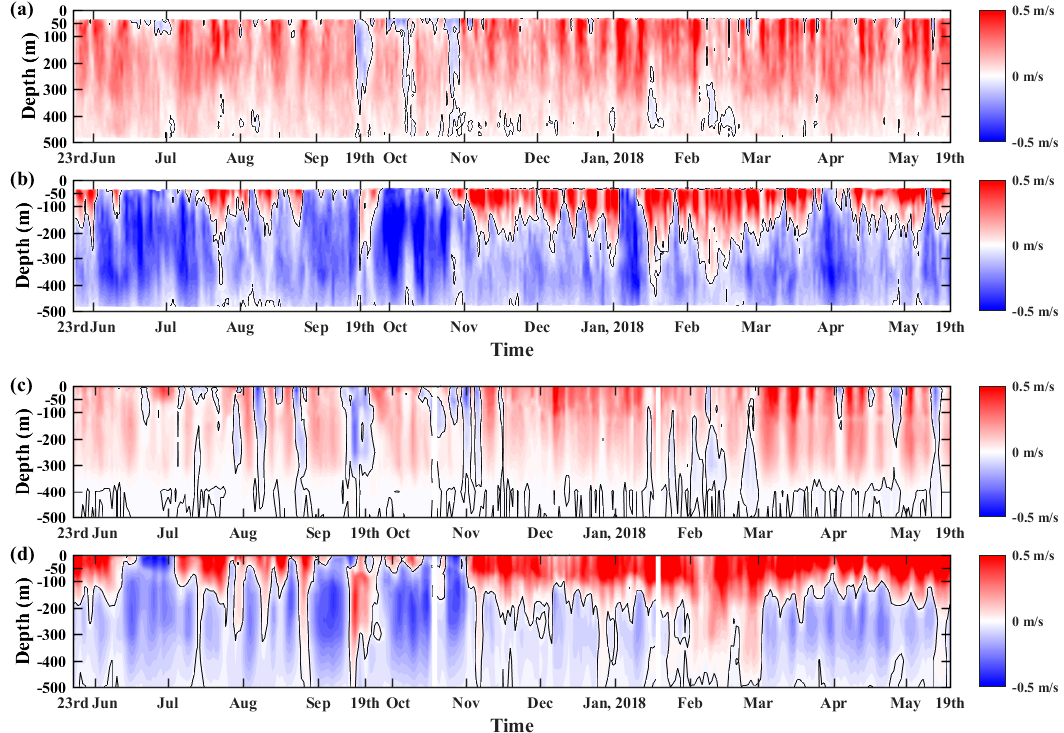
Figure 2. Current velocity distribution as a function of depth and time derived from ( a, b ) in situ observations and ( c, d ) analysis data. Panels a and c represent cross-shelf velocities, where red (blue) color indicates shoreward (seaward) velocity; panels b and d represent along-shelf velocities, where red (blue) color indicates northeastward (southwestward) velocity. Black contour denotes 0 m/s.